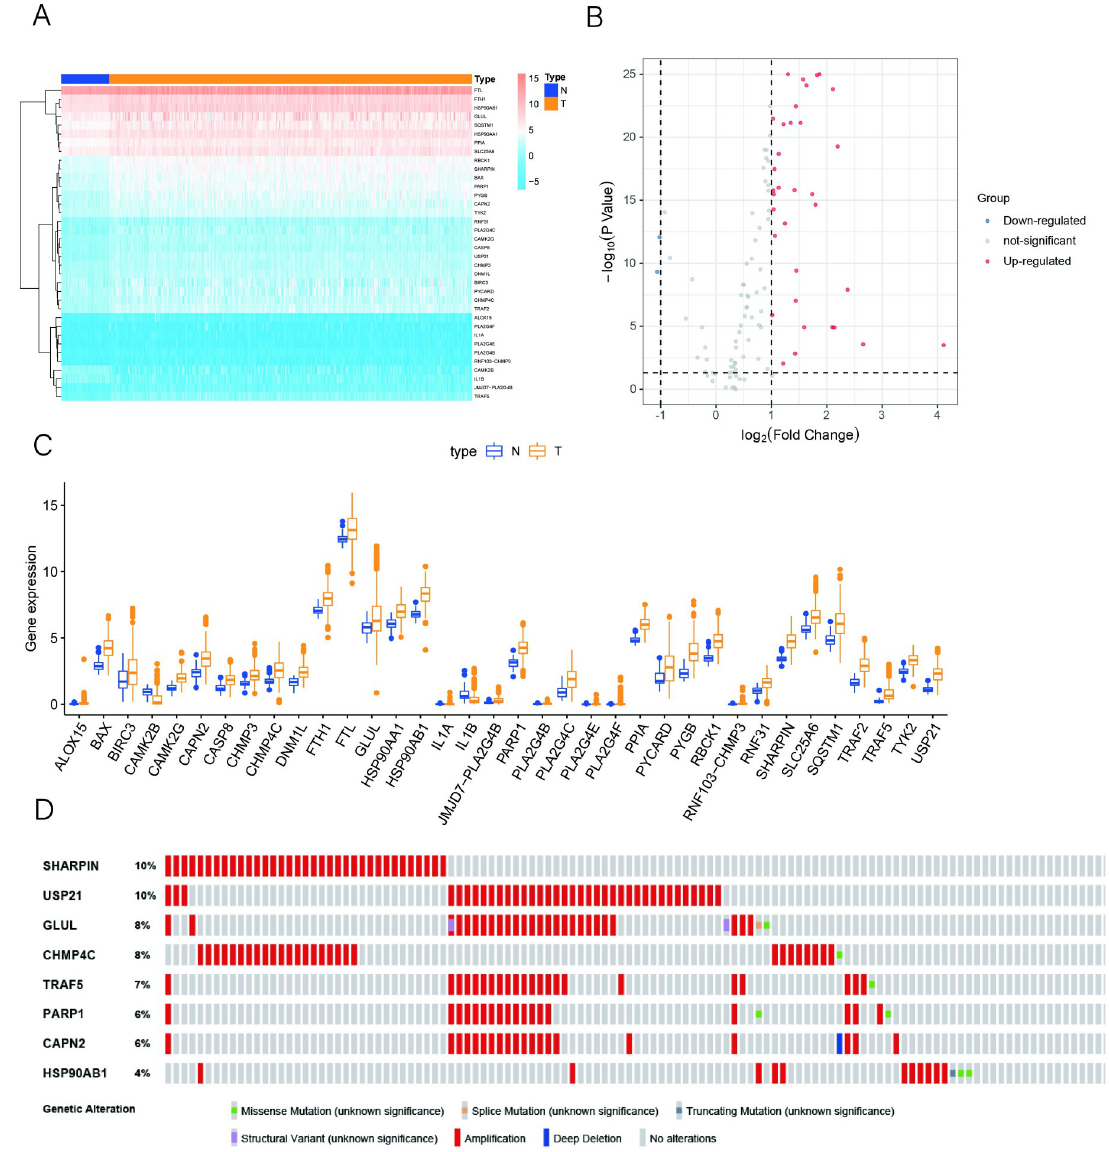
Fig 1. Differential expression analysis. (A) Heatmap of 36 differentially expressed NRGs based on their expression levels. (B) The volcano plot of the differentially expressed NRGs. (C) Boxplot of the expression of necroptosis-related DEGs. N indicates nontumor tissues; T indicates tumor tissues. (D) Mutations in NRGs. A total of 8 genes had a mutation rate �